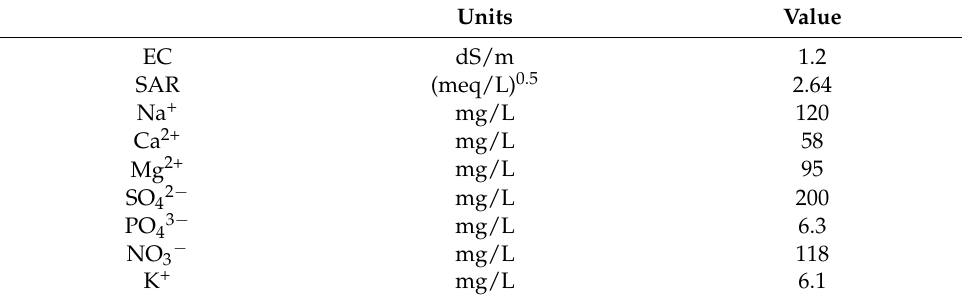
Table 2. The chemical characteristics of irrigation